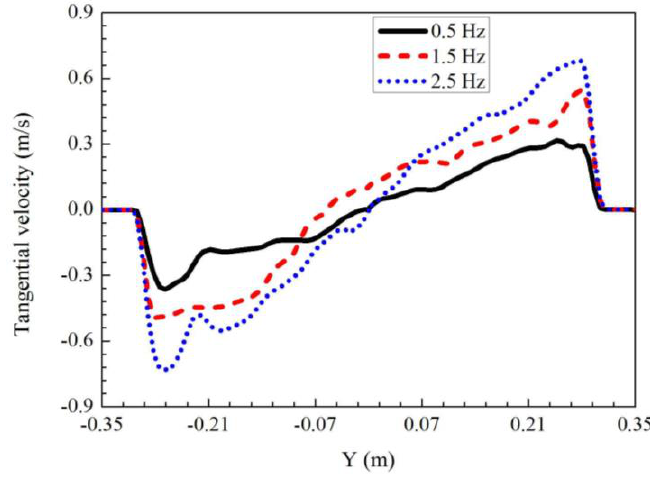
Figure 11. Tangential velocity at solidification front with different frequencies.